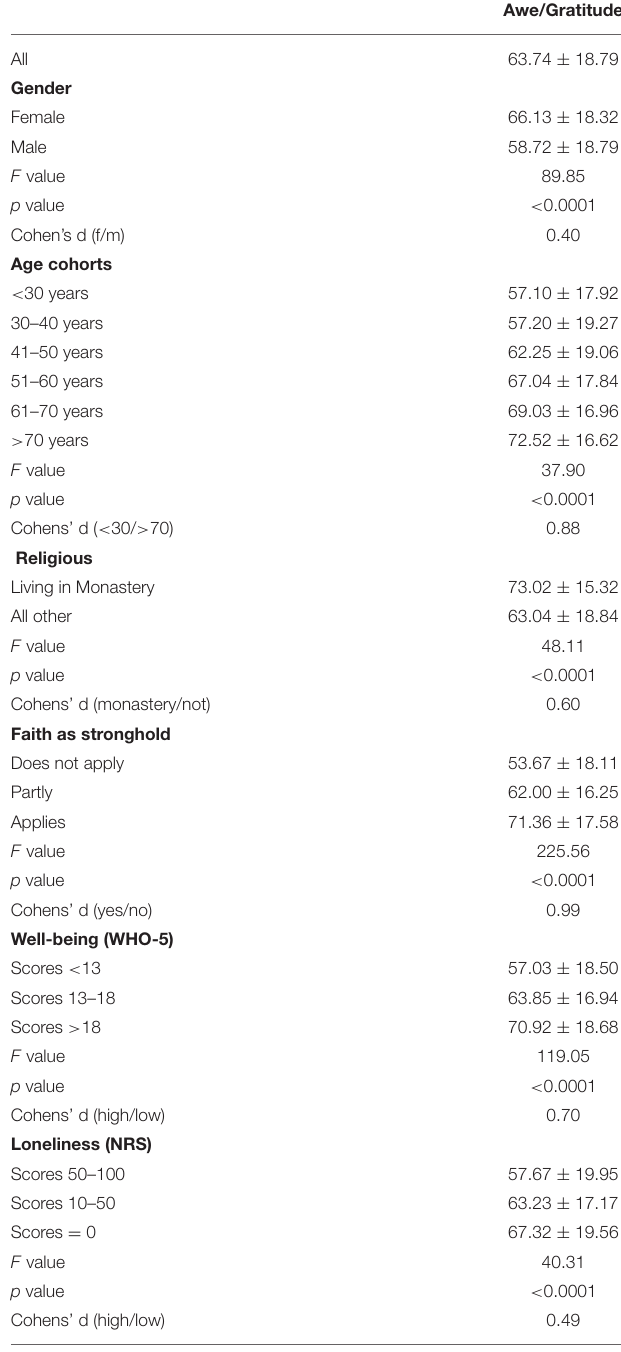
TABLE 3 | Awe/Gratitude in different subgroups.